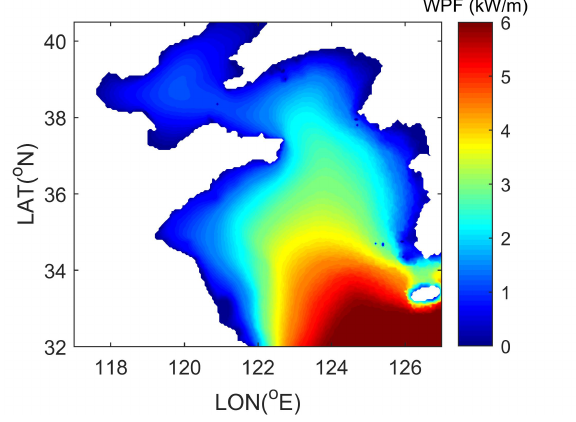
Figure 7. Total wave power average (1979–2018) at the YS and BS.